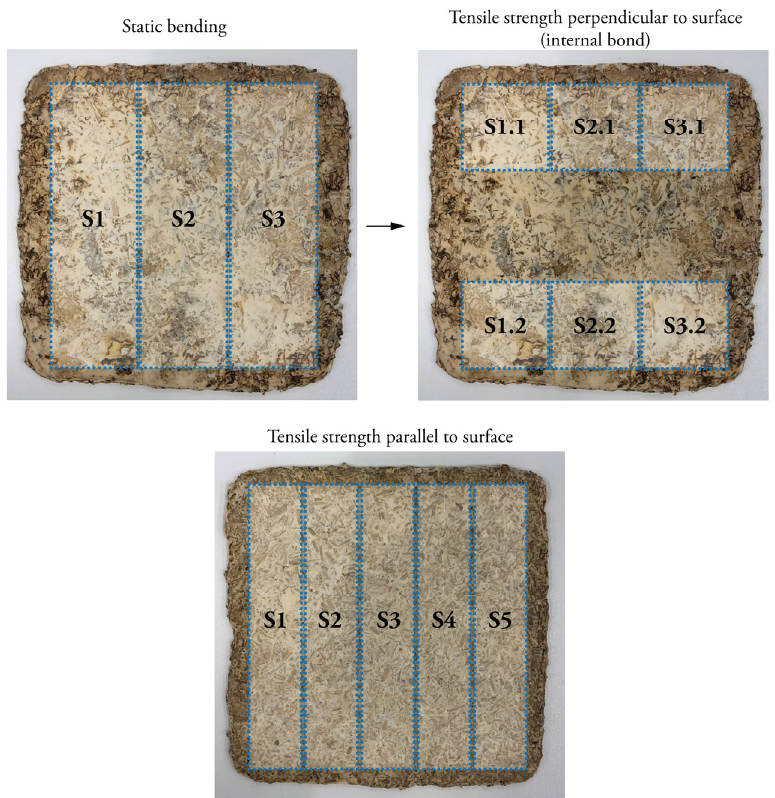
Figure 2. Example of the cutting pattern of specimens for the different mechanical tests.